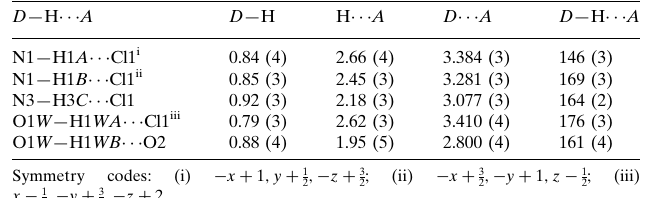
Hydrogen-bond geometry (A˚ , (cid:4)